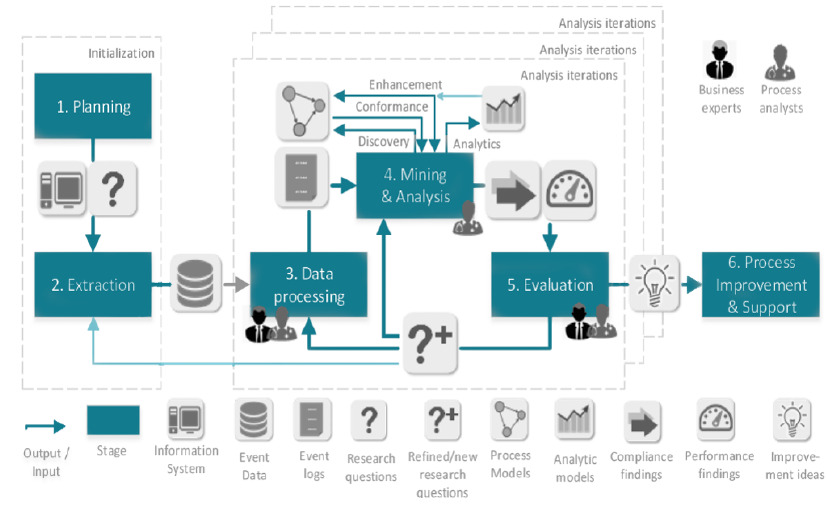
Figure 3. The PM 2 methodology